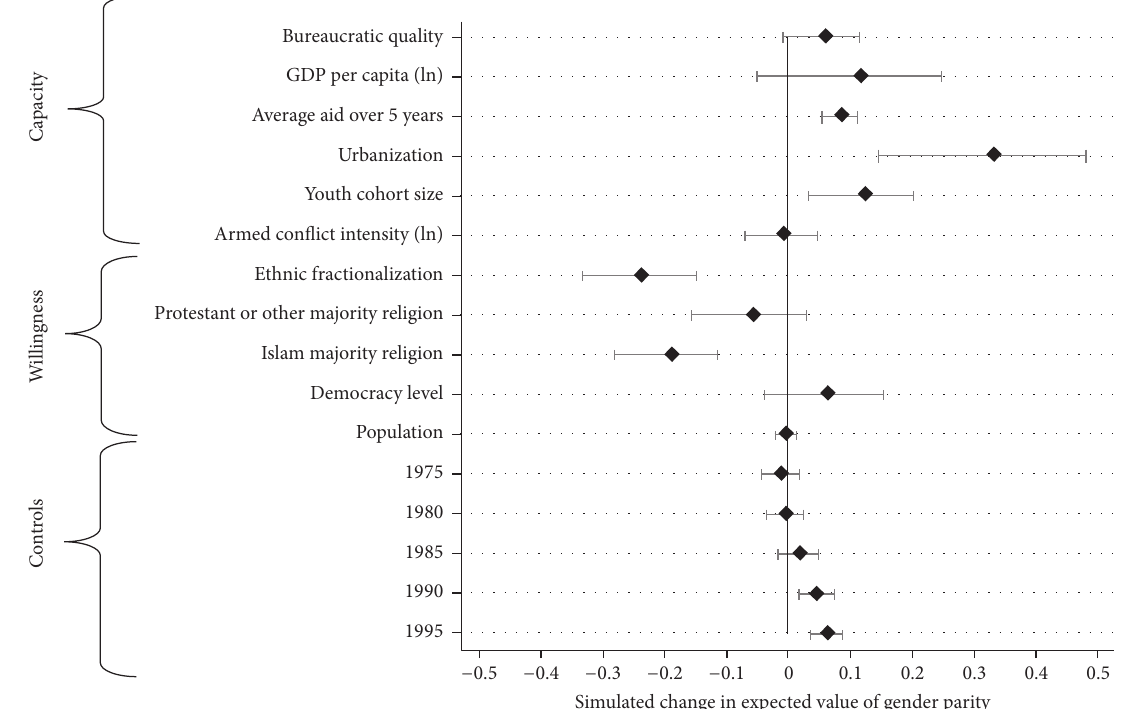
Figure 4: Simulated change in expected value of gender parity in secondary education attainment, developing countries: 1970–2010.